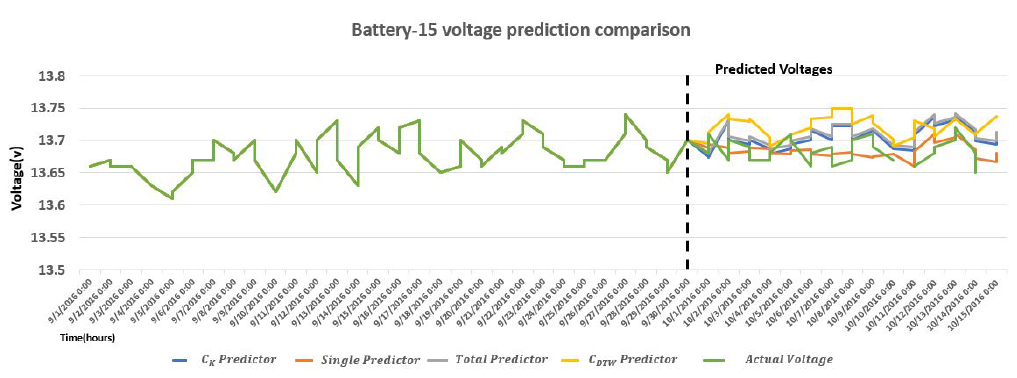
Figure 12. Comparison of measured and ARIMA forecasted voltage with C K , Single, Total, and C DTW predictor of Battery 15 from cluster